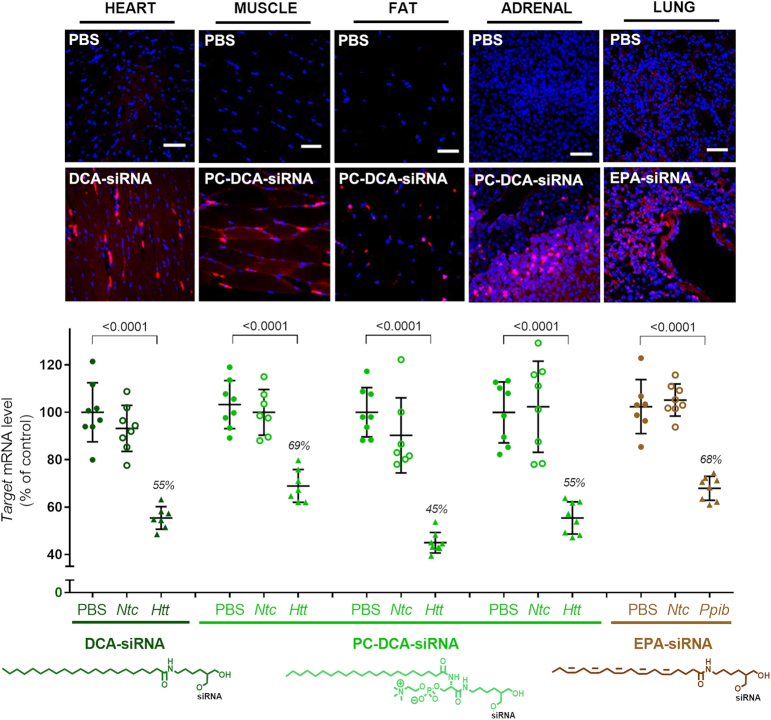
Accumulation of conjugated siRNA in several extra-hepatic tissues such as heart, muscle, fat, adrenal glands and lung are sufficient to induce mRNA silencing. Representative fluorescence images of heart, muscle, fat, adrenal glands and lung sections from mice injected subcutaneously with 20 mg/kg Cy3-labeled lipid-conjugated siRNAs or PBS. Nuclei stained with DAPI. Three mice per conjugate were injected and tissue collected after 48 h. Images taken at 40 × magnification and collected at the same laser intensity and acquisition time. Scale, 50 μm. For the measurement of Huntingtin (Htt) or Cyclophilin B (Ppib) mRNA levels, mice were injected subcutaneously with 20 mg/kg of conjugated siRNA (n = 16 per conjugate: 8 with siRNA targeting Htt and 8 with siRNA targeting Ppib, as well as non-targeting controls). The tissues were collected after 1 week and mRNA levels were measured using QuantiGene® (Affymetrix), normalized to a housekeeping gene, Hprt (Hypoxanthine-guanine phosphoribosyl transferase) and presented as percent of PBS control (mean ± SD).